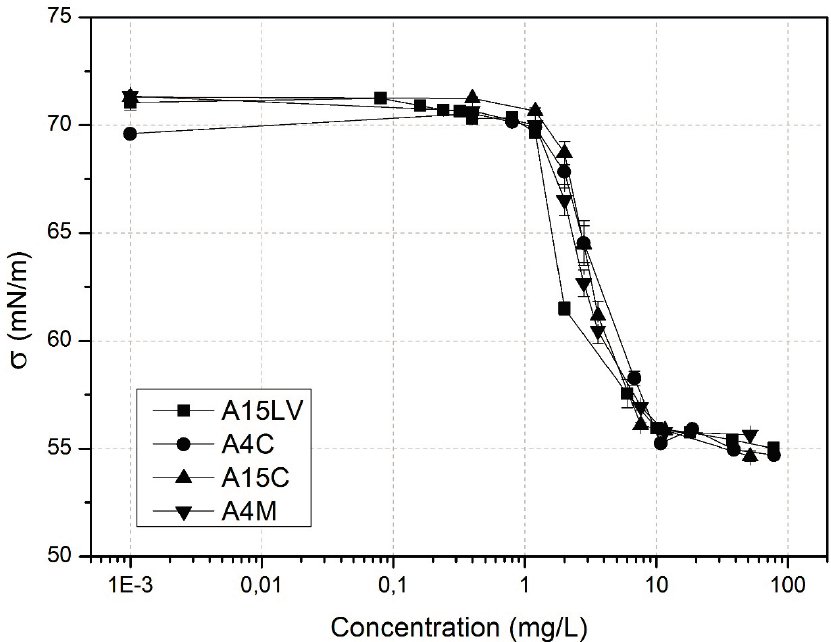
Figure 11. Influence of the molecular weight on the tension-active properties ( σ in mN/m) of MC with different molecular weights as a function of polymer concentration at 20 °C. The lines are added to guide the eye